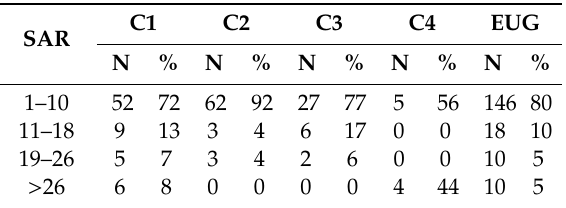
Table 8. Distribution of the SAR (Sodium Adsorption Ratio) within the 4 sub-basins. N: number of